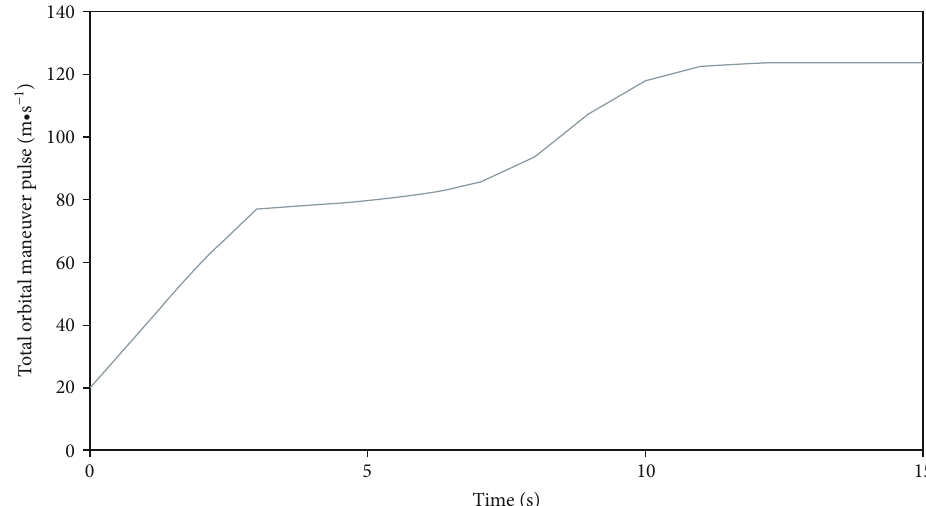
Figure 14: The time variation curve of the spacecraft ’ s total orbital maneuver pulse at the stage of approaching from a close